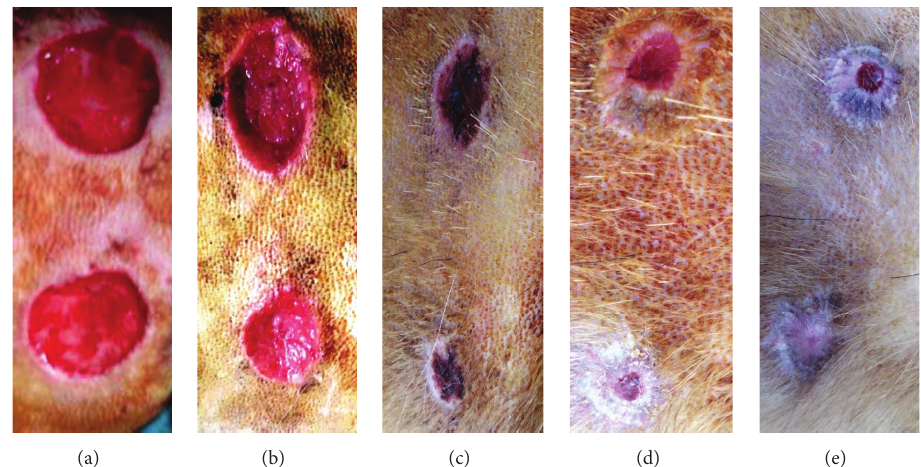
Figure 1: Representative skin wounds of the control group (upper wounds) and propolis group (lower wounds) at 0 (a), 7 (b), 14 (c), 21 (d), and 28 (e) days after